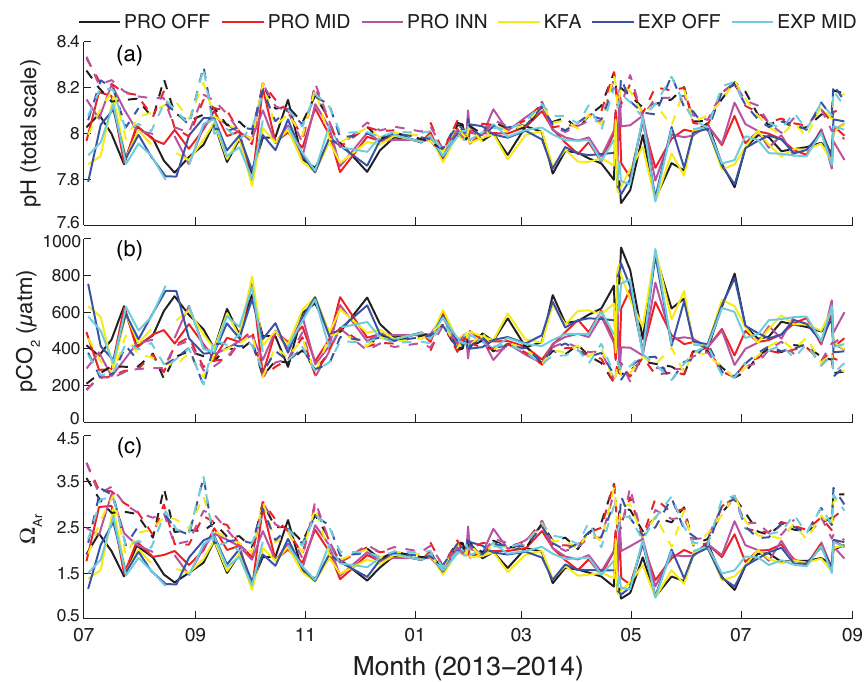
Figure 5. Time series of (a) pH, (b) p CO 2 , and (c) (cid:127) Ar calculated from TA and DIC measurements. Solid lines are bottom samples and dashed lines are surface samples.